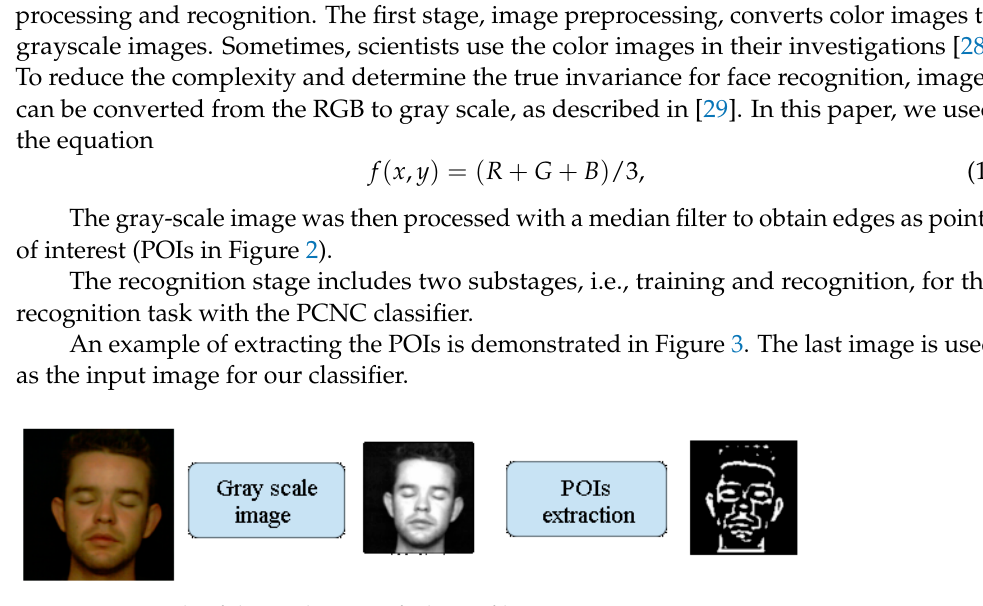
Figure 3. Example of the application of a linear filter.